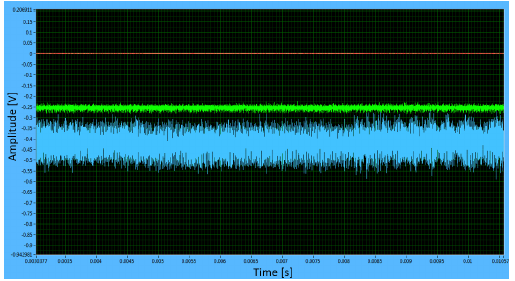
Figure 6. Noise reduction after low-pass filter imple- mentation (green) and before (blue).